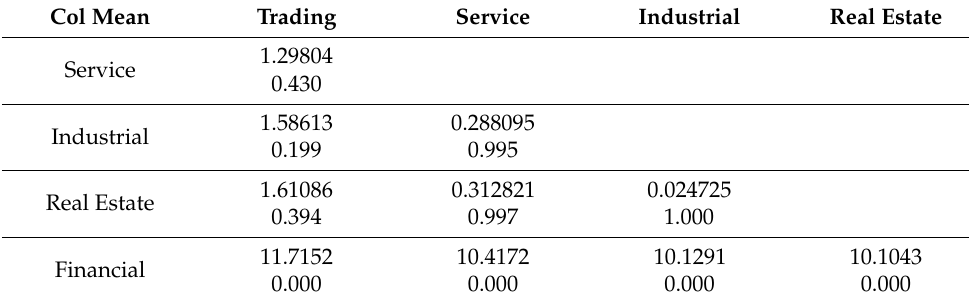
Table 7. Comparison of all FI disclosures by industries (Scheffe) row